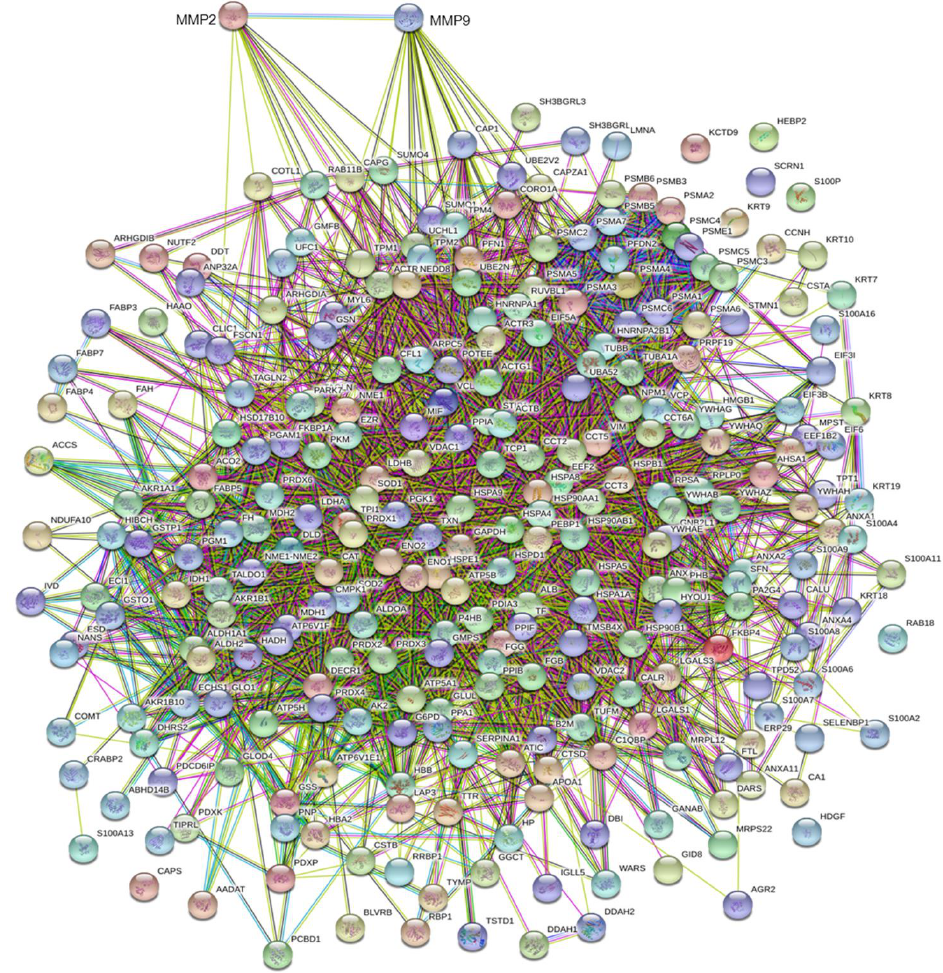
Figure 5. Interactome of the 274 genes coding for the 458 protein spots identified on the proteomic maps of the 80 breast cancer tissues selected for the study. The interactome was obtained by the software STRING, available online [18]. MMP-2 and MMP-9 were added to the list of 274 genes, in order to trace their predicted interactions with the proteomic profiles of the selected breast tissues.